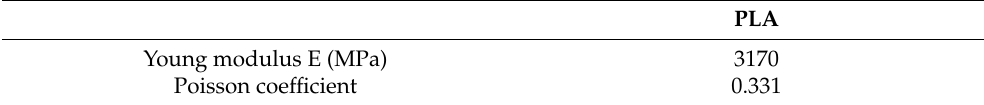
Table 2. Materials parameter used in numerical calculations.